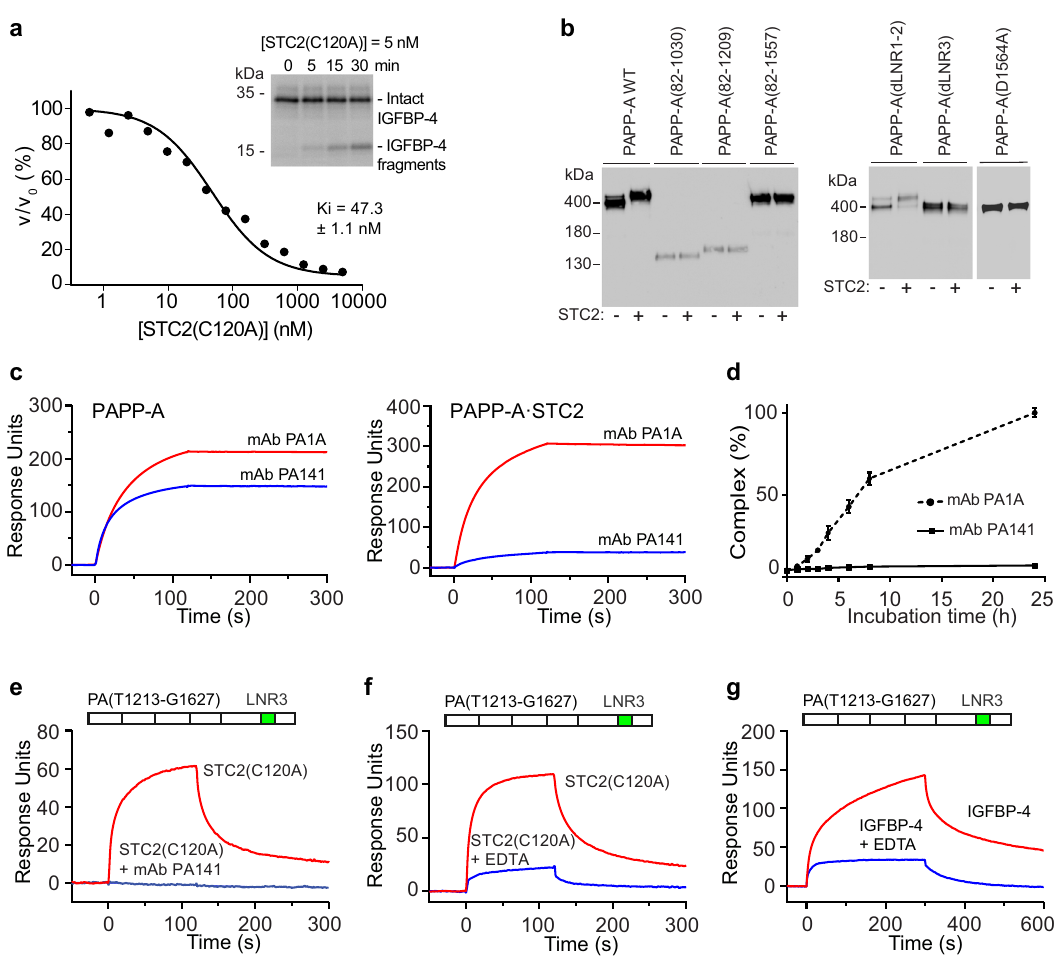
Fig.8|Kineticsandinteractionanalyses.a KineticanalysisofinhibitionofPAPP-A cleavageofIGFBP-4bySTC2(C120A).STC2(C120A)cannotbindcovalentlytoPAPP- A. Intact radiolabeled IGFBP-4 was used, and relative initial velocities (v/v 0 ) of the cleavage reaction were determined by quanti fi cation of IGFBP-4 and